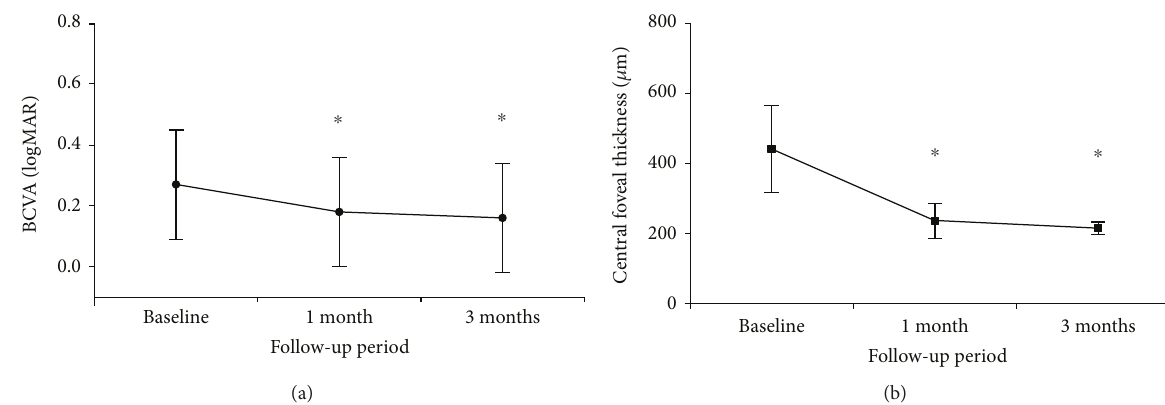
Figure 4: Changes in best-corrected visual acuity (BCVA) (a) and central foveal thickness (b) after selective retinal therapy. There was a signi fi cant improvement in BCVA accompanied with signi fi cant decrease in central foveal thickness after treatment. Asterisks indicate signi fi cant di ff erence when compared to the baseline value. logMAR: logarithm of minimal angle of